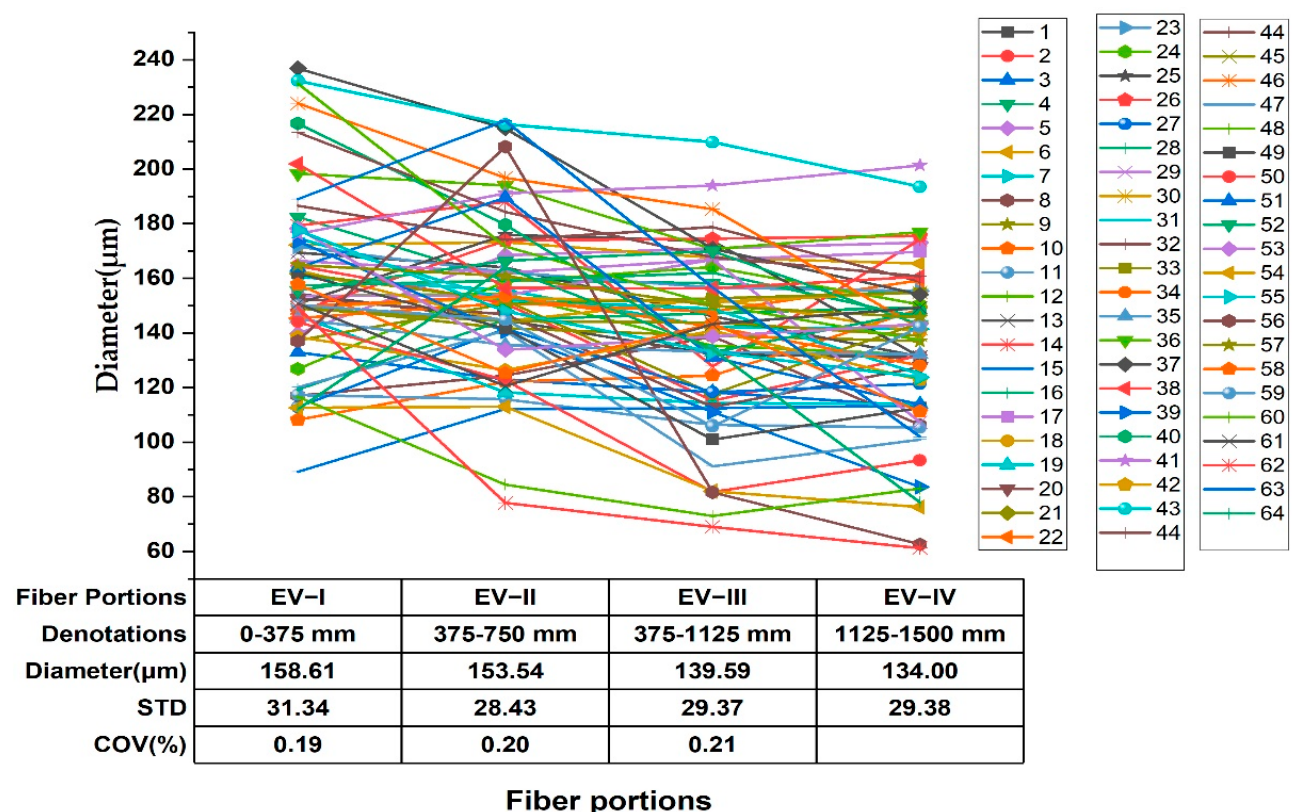
Figure 3. Enset bundle fiber portion versus fiber bundle diameter.